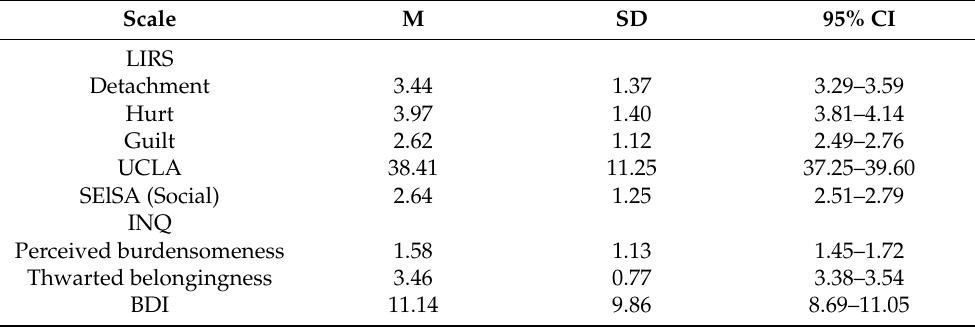
Table 5. Descriptive statistics of the study measures—Study 4.